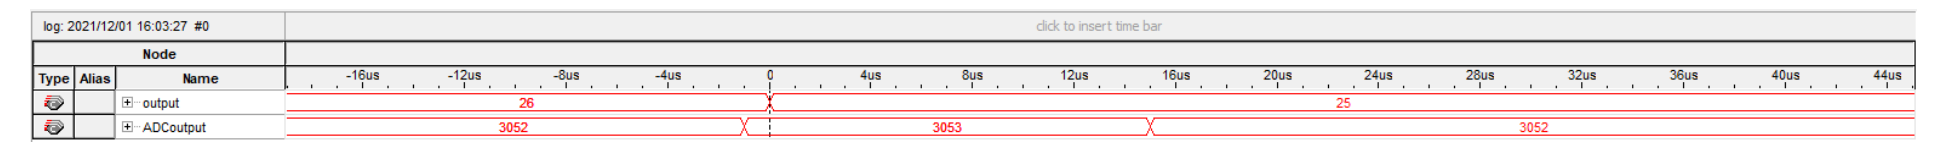
Figure 23. Error analysis for 60 periods of a SPSS signal with ±30° at 1.2 Hz with D = 100 cm.